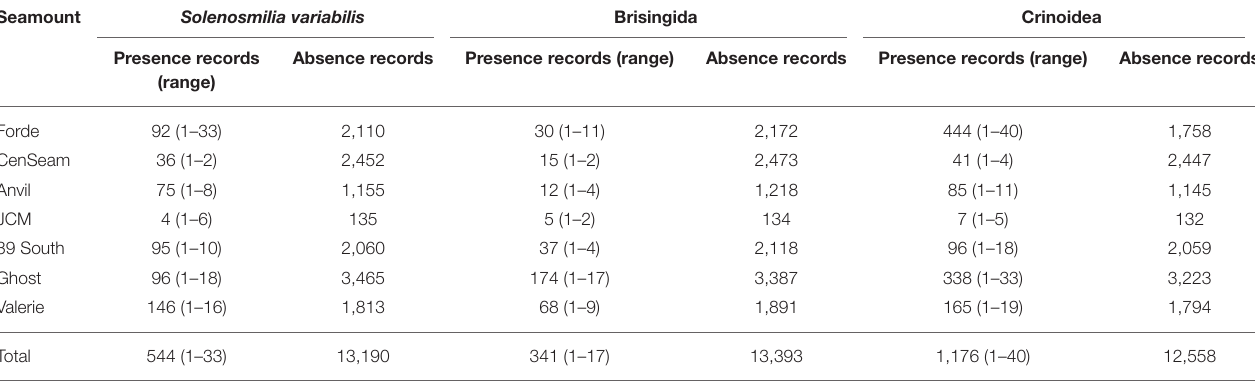
TABLE 2 | VME indicator and habitat indicator taxa, the number of presence and absence records, and for presence records, the minimum and maximum number of records per video transect segment (25 m 2 ). Seamount